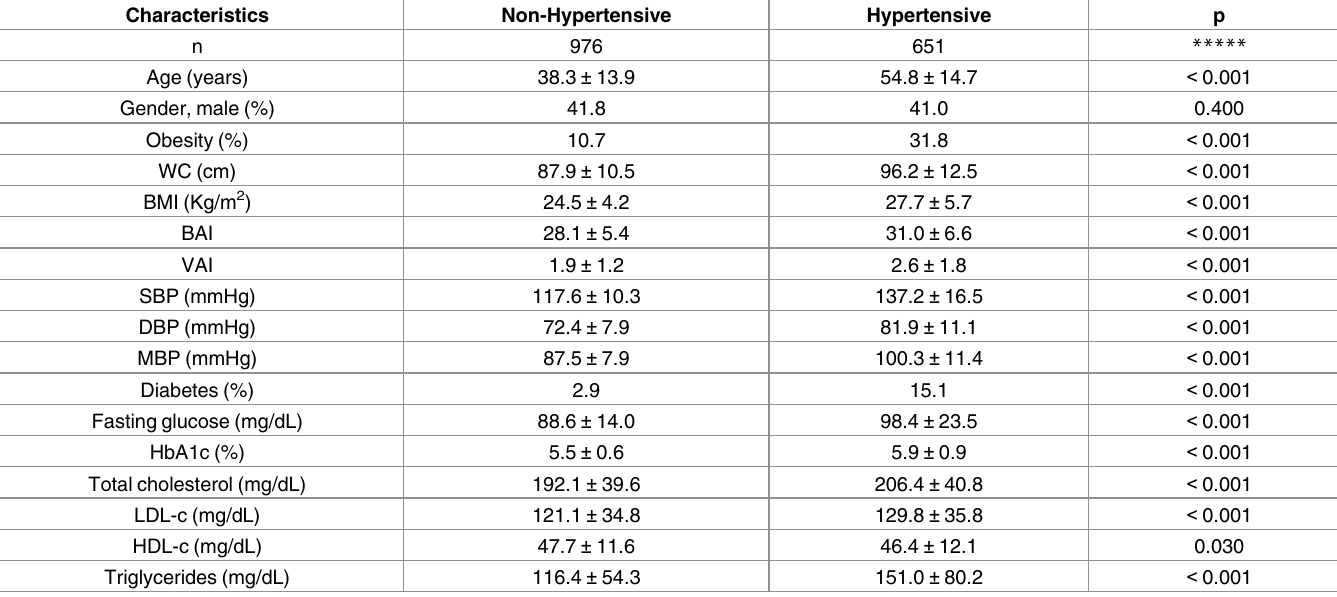
Table 1. General characteristics of subjects stratified by